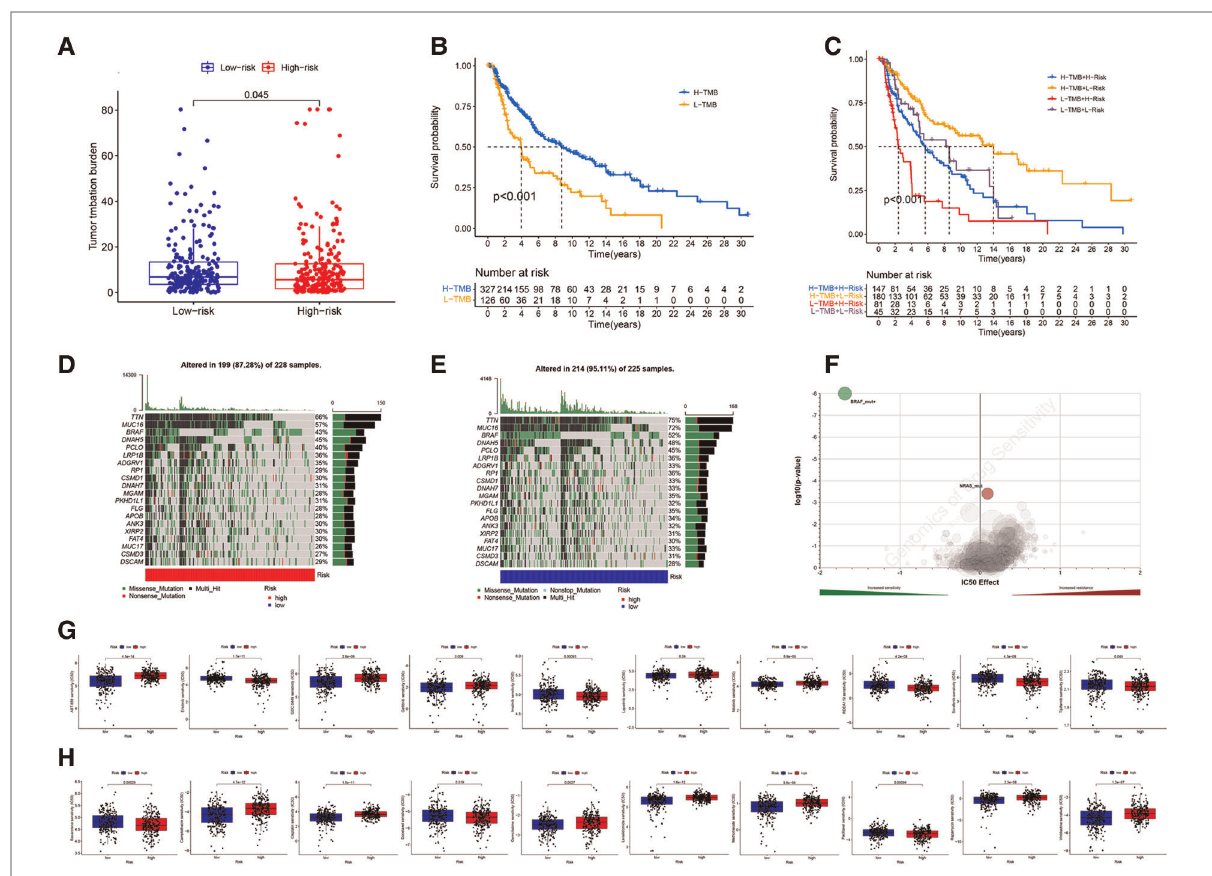
FIGURE 9 TMB and drugs sensitivity analysis. ( A ) The TMB in different risk groups. ( P <.001). ( B,C ) The prognostic performance of TMB scores in survival cures. ( D – E ) The mutation rates of the top 20 genes in different risk groups. ( F ) The IC50 score with mutation. ( G ) The target drugs sensitivity in different risk groups. ( H ) The Chemotherapy drugs sensitivity in different risk